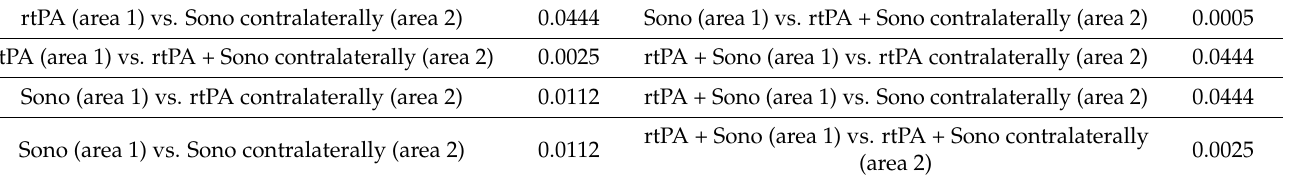
Table 2. p values of the comparison between GFAP immunohistochemistry perihematomal (area 1) and contralaterally (area 2) to the